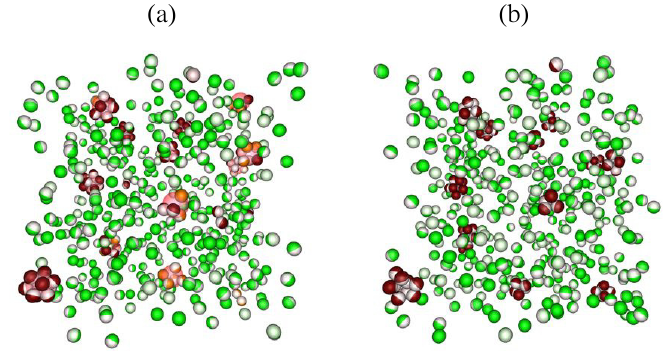
Figure 2. Simulation snapshots of the mixture for Janus colloids ( χ = 1/2) and droplets. Results are shown at two different stages of the time evolution: ( a ) after 3.25 10 5 MC cycles and ( b ) after 10 6 MC × cycles. Droplets are depicted as pink spheres. Each Janus colloid has two hemispheres where the white hemisphere corresponds to the attractive patch, and the green one is the repulsive patch. When colloidal particles are trapped at the droplet surface or in droplet-induced clusters, the repulsive part of Janus colloids are shown in